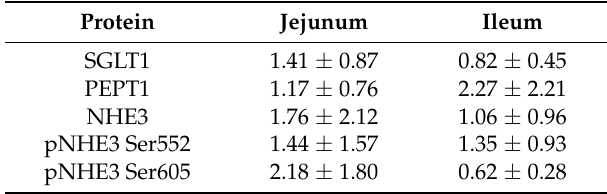
Table 1. Association of transport proteins with the DRM fraction prepared from jejunal and ileal apical membranes after incubation with resveratrol (300 µ M, 30 min) expressed as changes (means ± SD) in the protein/flotillin-1 ratio. The change in protein/flotillin-1 ratio was calculated (the protein/flotillin-1 ratio for resveratrol-treated tissues was set in relation to preparations from control tissues ( n = 6, n = 4 for pNHE3 Ser605 Ileum)).